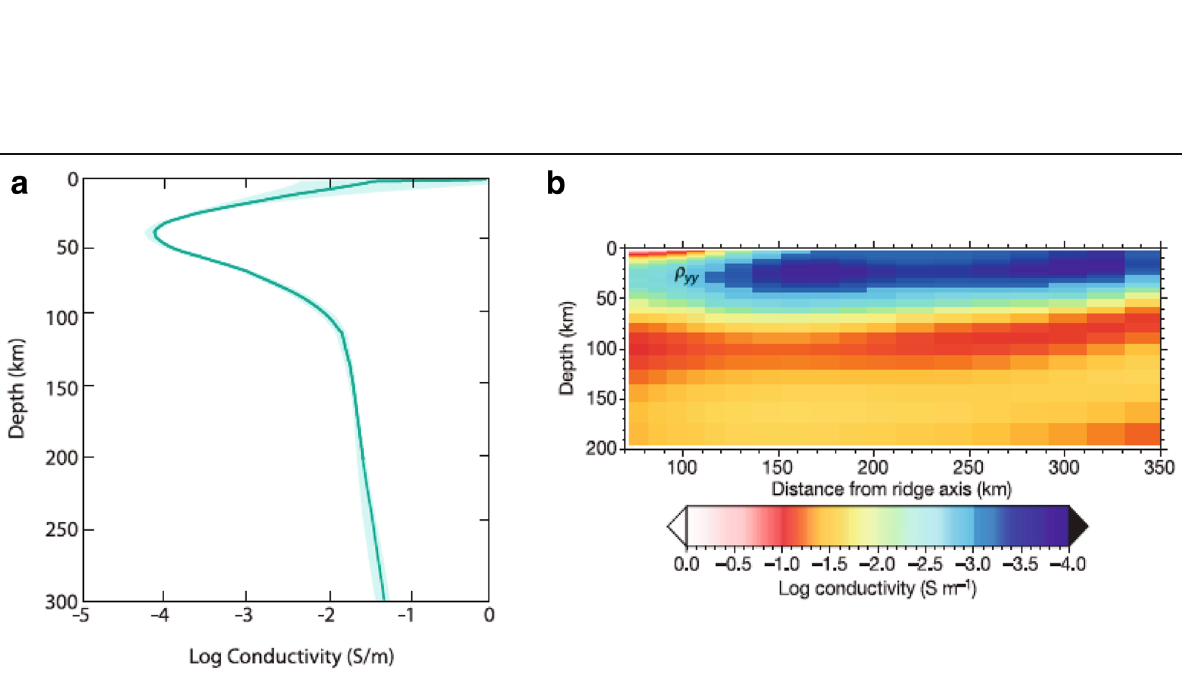
Fig. 10 Geophysical models of electrical conductivity in the oceanic upper mantle from the magnetotelluric observations. a Results away from the mid-ocean ridge (from Sarafian et al. 2015). Mid Pacific (70 Myrs old oceanic region). Electrical conductivity increases smoothly with depth without any peak. b Results near the east Pacific Rise (from Evans et al. 2005). There is a peak in conductivity at the top of the asthenosphere. Some anisotropy is also reported (high along the direction of plate motion, low normal to it both in the horizontal plane)